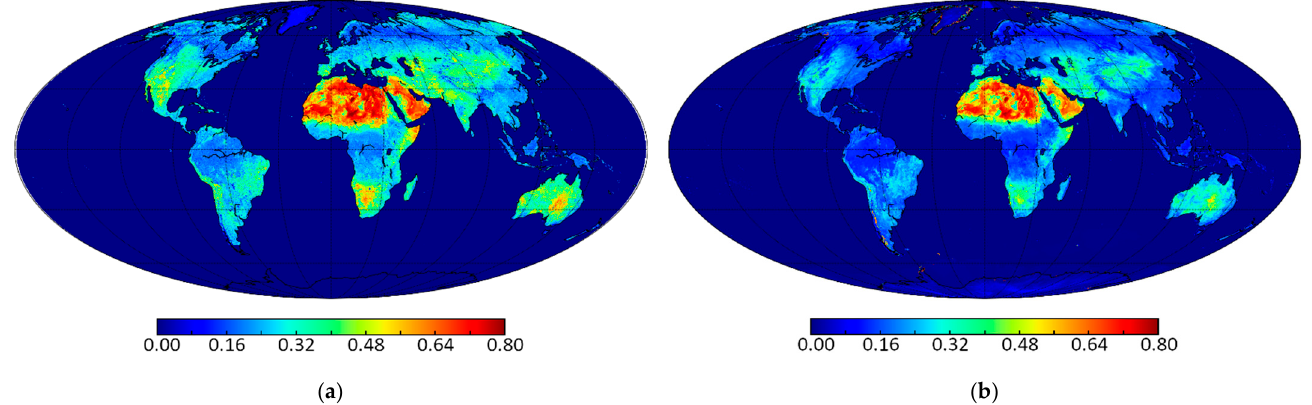
Figure 8. Global maps of zenith reflectance around 1.6 µ m on a monthly basis (here June). ( a ) for a nadir incidence (hot spot configuration), the map provided by the company Estellus under a CNES contract, over the continents with a lat/lon resolution of 1/120°. These data are used for the laser fl uxes even though, with an incidence angle of − 1°, there is no specular reflectivity in the MERLIN context. ( b ) for a solar incidence angle of 65°, the map provided by the company Noveltis under an ESA contract [46], with resolution of 1/10°. These data are used for sunlight even if the incidence angle (given the choice of orbit) is larger as the database has too many artefacts at higher angles of incidence.